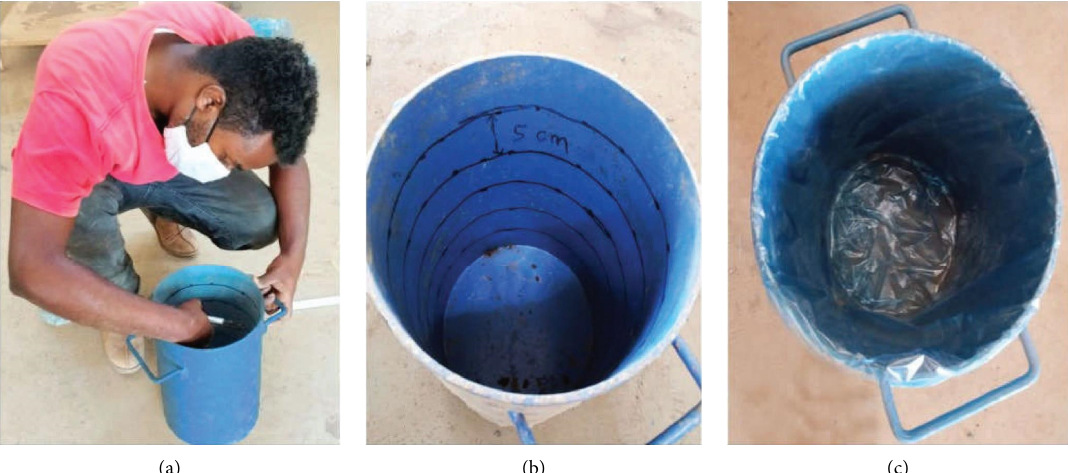
Figure 5: Preparation of test tank: (a) marking test tank at 5cm vertical spacing to control compaction, (b) marked test tank, and (c) greasing and covering inner surface of the test tank with plastic